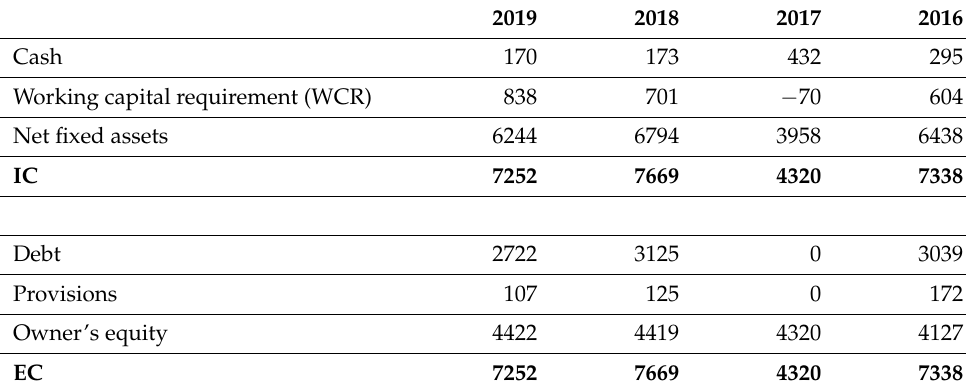
Table 11. Managerial balance sheet of Geotermia Czarnków Sp. z o.o. (PLN thousand).